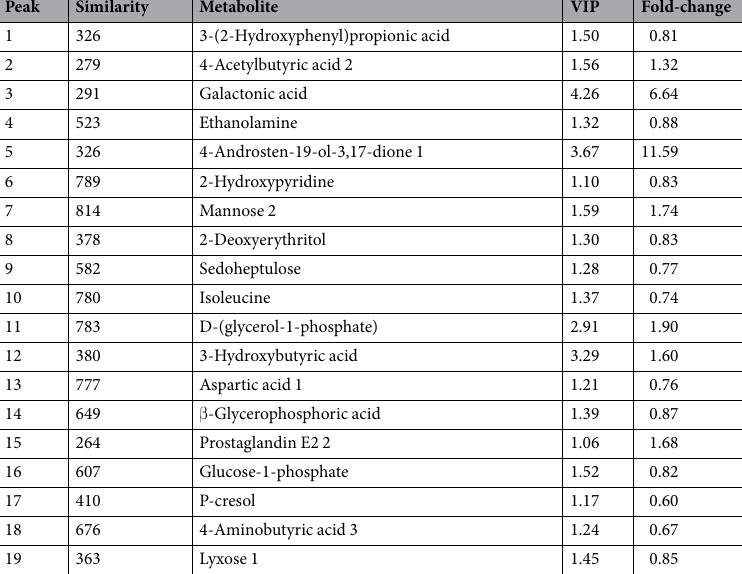
Table 3. Discrepant metabolites identified by GC-TOF/MS analysis between early-stage NSCLC patients and HC.